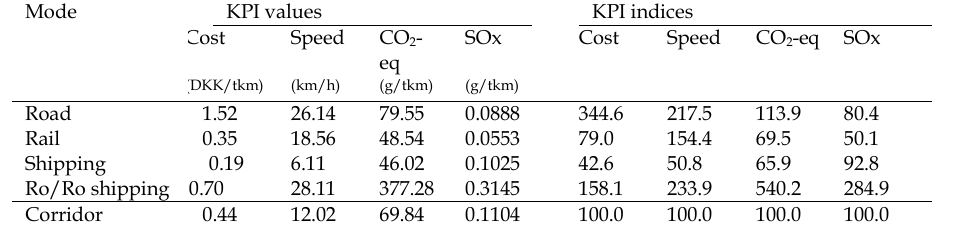
Table 4. KPI values and indices by mode